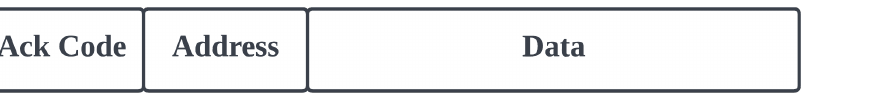
Figure 5. Message payload components. The message payload consists of three components: the acknowledgment (Ack) code, sender address, and data.